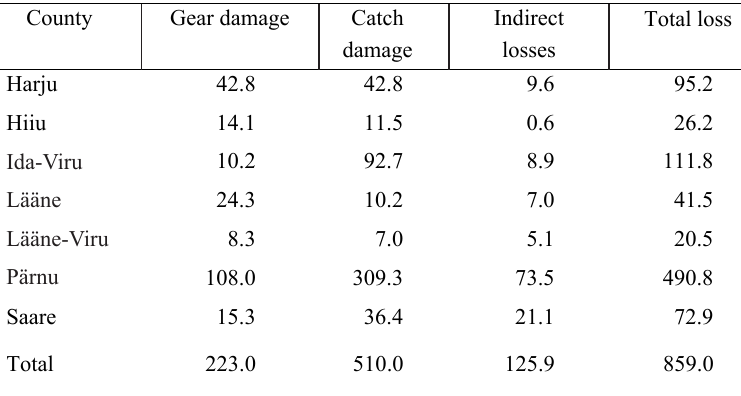
Table 1. Calculated monetary losses (in thousand euros) caused by seals in coastal counties in 2009. The bulk of the indirect losses corresponds to interrupted fishing